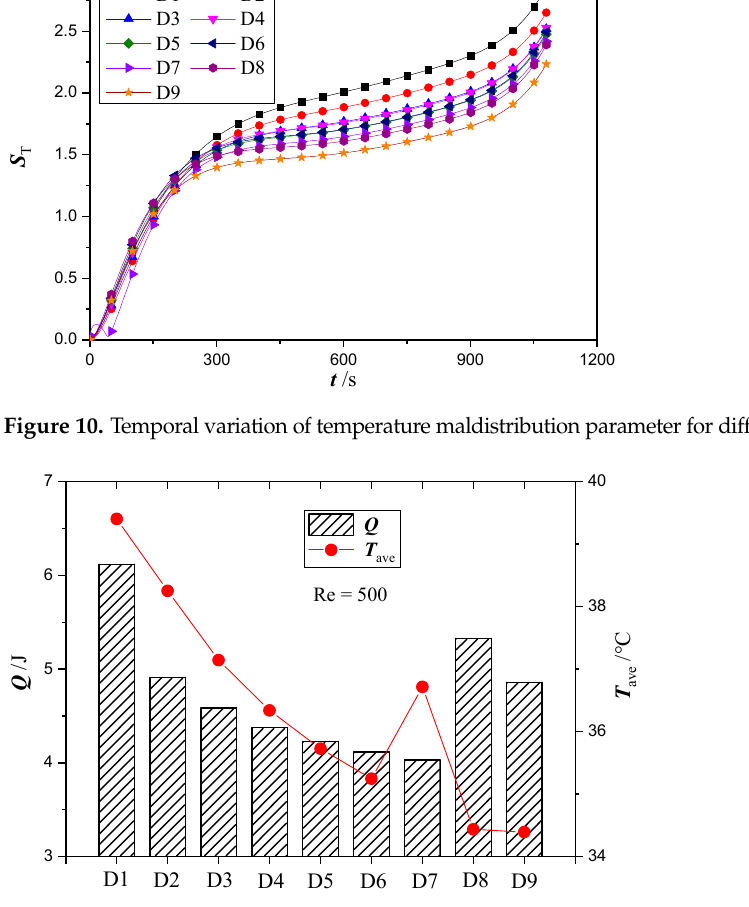
Figure 11. The comparison of the total energy consumption and ba tt ery temperature between dif- ferent cold plate designs at Re = 500. different cold plate designs at Re =